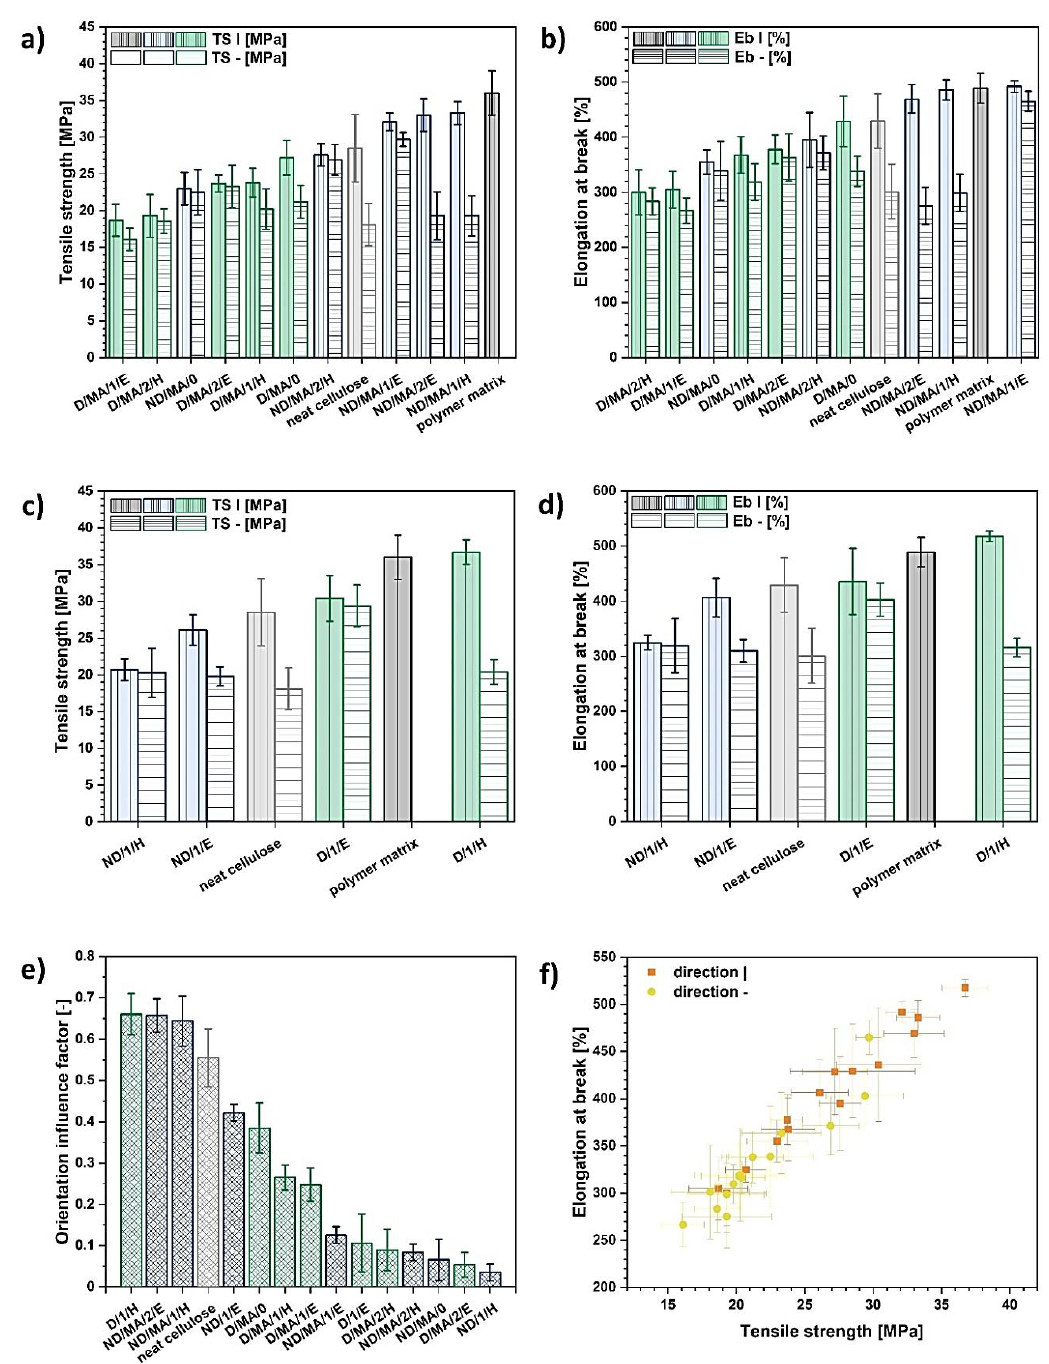
Figure 1. Tensile properties comparison: tensile strength and elongation at break of hybrid chemically modified cellulose-filled ( a , b ) and solvent-treated cellulose-filled ( c , d ) polymer composites, orientation influence factor ( e ), elongation at break as a function of tensile strength ( f ) for all investigated composite samples; TS, tensile strength (MPa); Eb, elongation at break (%); | ,- direction of cutting out of the specimens. Cellulose loading: 14 wt%.